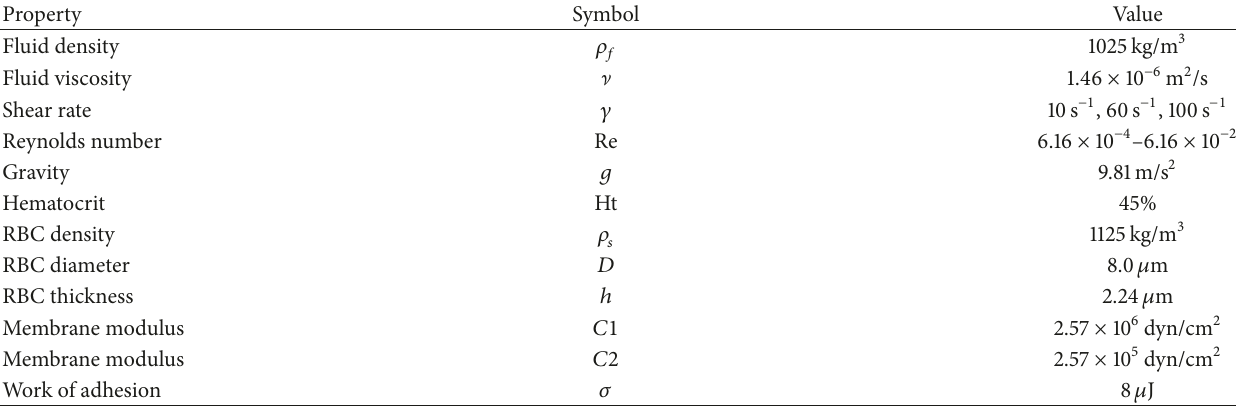
Table 2: Physical properties of the fluid (plasma) and solid (RBC).